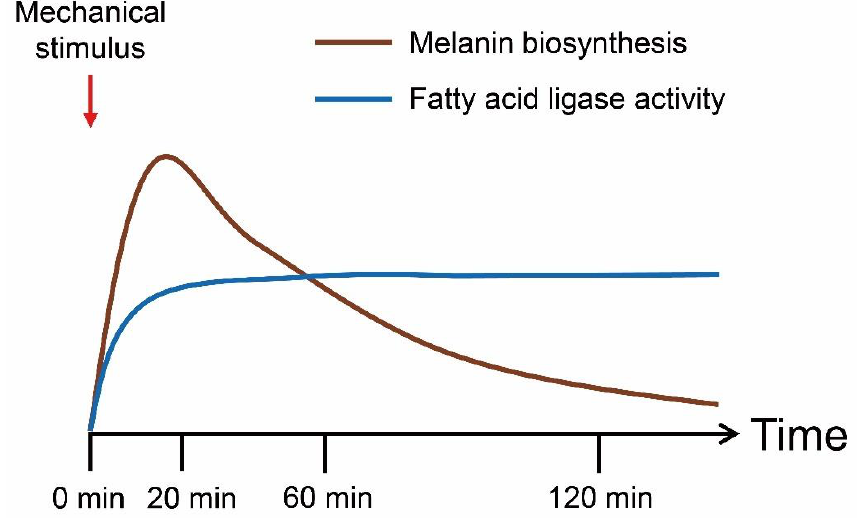
Figure 5. Proposed transcriptomic response after mechanical stimulus in A. bisporus .